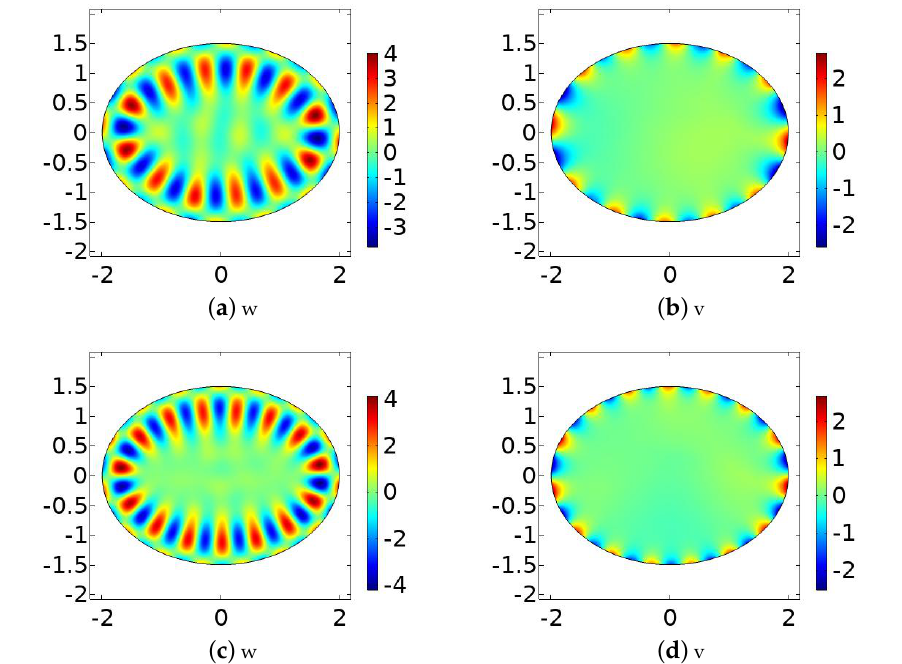
Figure 3. The magnitude of transmission eigenfunctions for an ellipse. ( a , b ): k = 1.983; ( c , d ): k =